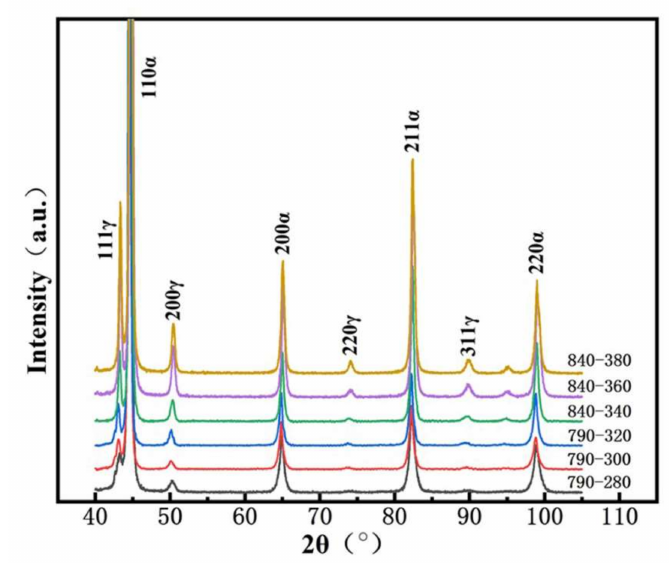
Figure 6. XRD patterns of the both steels austempered at different heat treatment